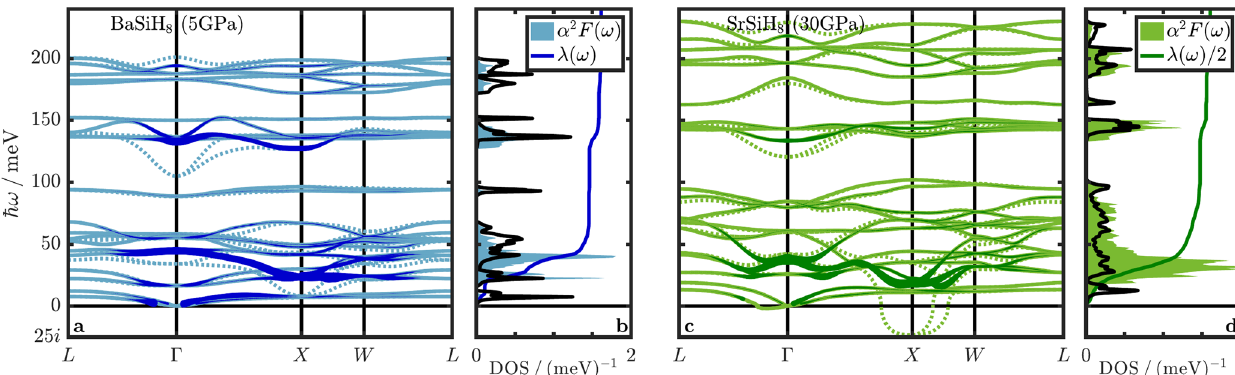
Fig. 2 Vibrational structure and electron-phonon properties. a Phonon dispersion of BaSiH 8 at 5 GPa; the thickness of the dark blue lines is proportional to the mode- and wave-vector resolved coupling constant λ q , ν . Solid (dotted) lines correspond to anharmonic (harmonic) results. b Phonon DOS shown as solid black line, α 2 F ( ω ) as fi lled curve, and λ ( ω ) as solid blue line. Panels c and d as a and b but for SrSiH 8 at 30 GPa.